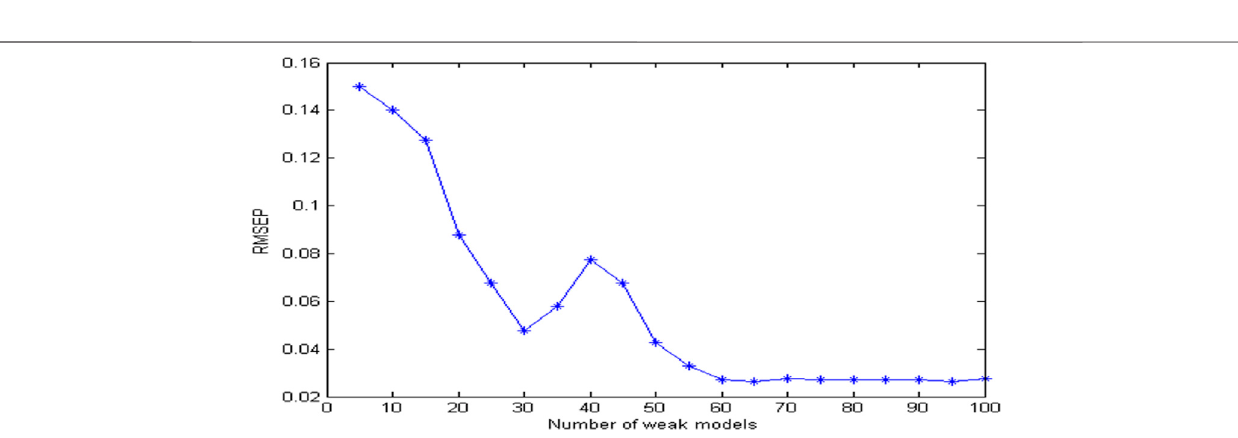
Frontiers in Chemistry |